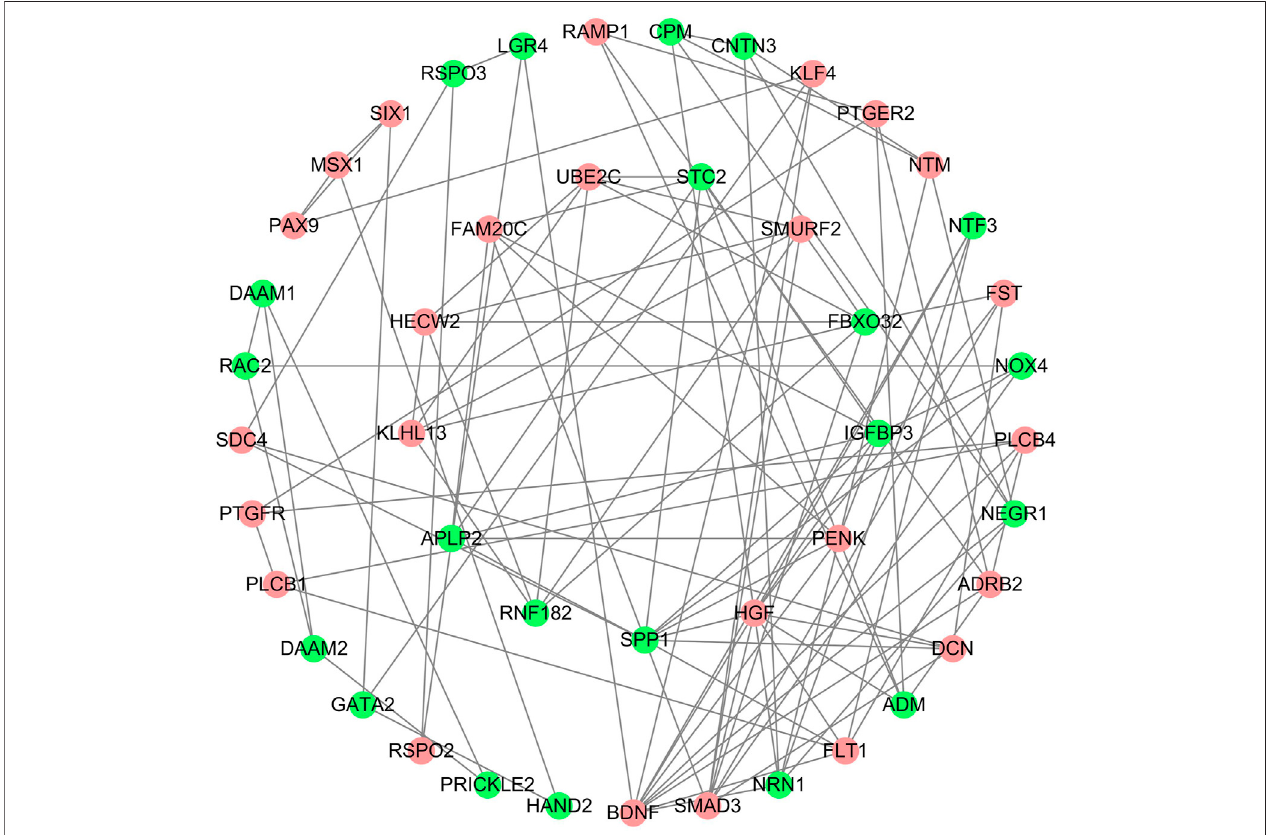
FIGURE5| PPInetworkconstruction,criticalmodulefromPPInetwork.Greencircles:down-regulationwithafoldchangeofmorethan2;redcircles:upregulation with fold change of more than 2.